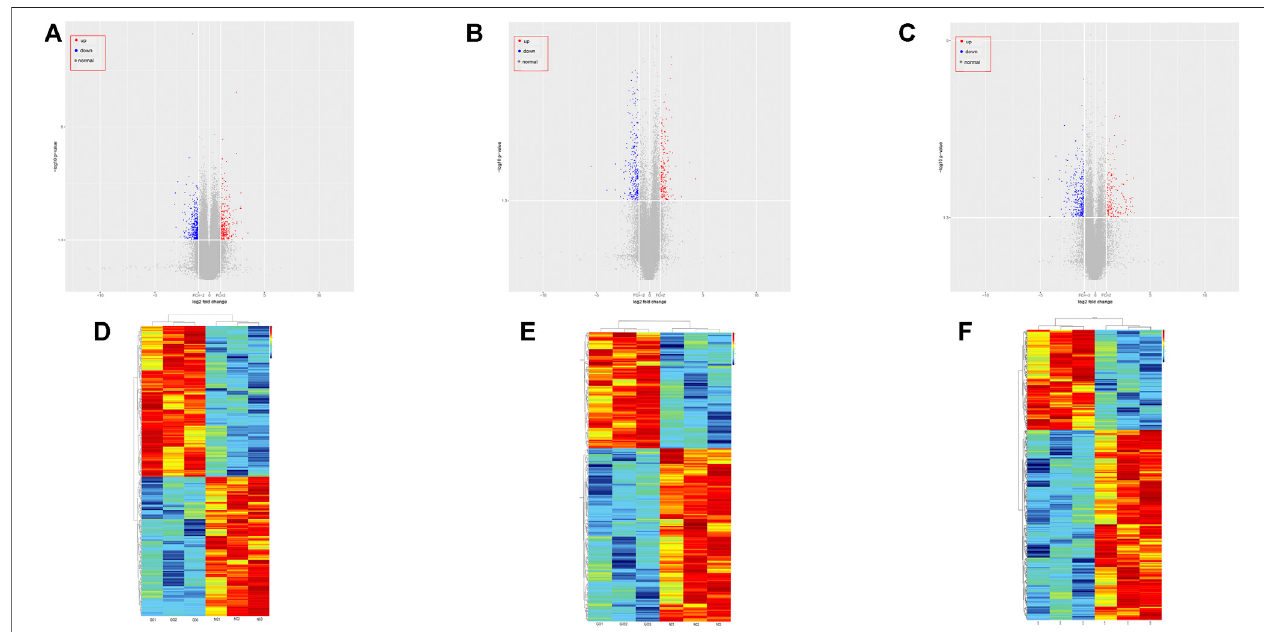
FIGURE1| Overviewoftheexpressionpro fi lesofncRNAandmRNAsequencingdatainpairedGravesophthalmopathyversusnormalcontrolgroups. (A) Volcanoplot ofcircRNAexpressiondataforthepairedGOgroupandcontrolgroup. (B) VolcanoplotofthelncRNAexpressiondataofthesametwogroups. (C) VolcanoplotofthemRNA expression data ofthe same two groups. (D) Hierarchical clustering heatmap ofcircRNAexpression data from the sametwo groups. (E) Hierarchical clustering heatmapof the lncRNA expression data of the same two groups. (F) Hierarchical clustering heatmap of the mRNA expression data of the same two groups.